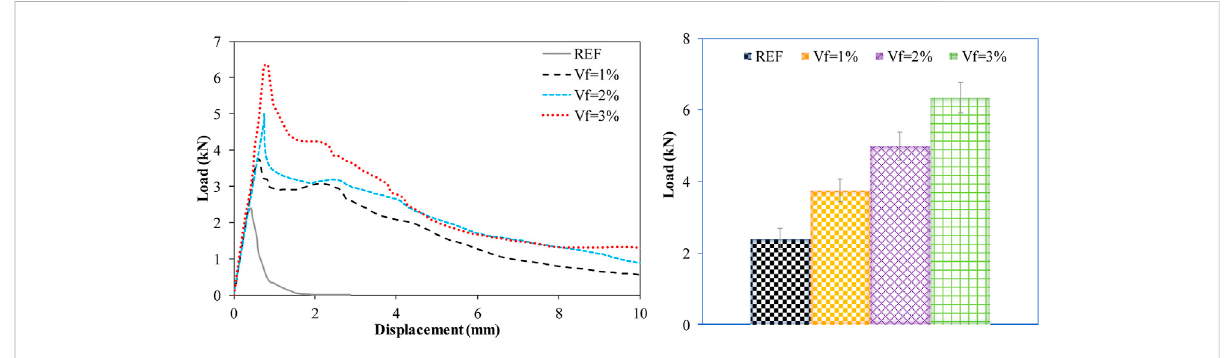
FIGURE 7 Effects of fi ber volume fraction on fl exural strength.